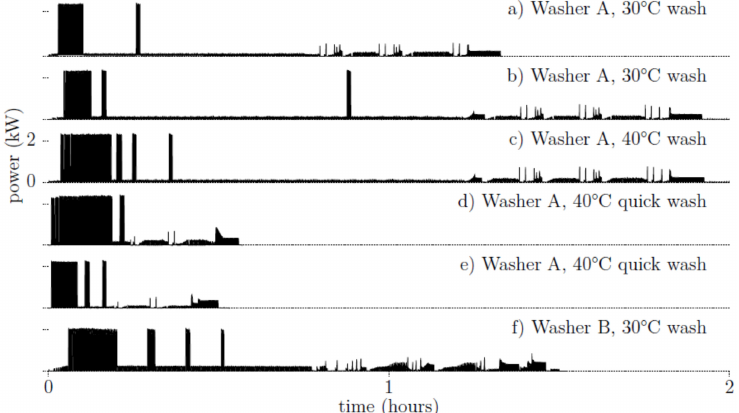
Figure 4. Taken from Hart’s US patent number 4,858,141 to map the di ff erences in reactive power to distinguish appliances.